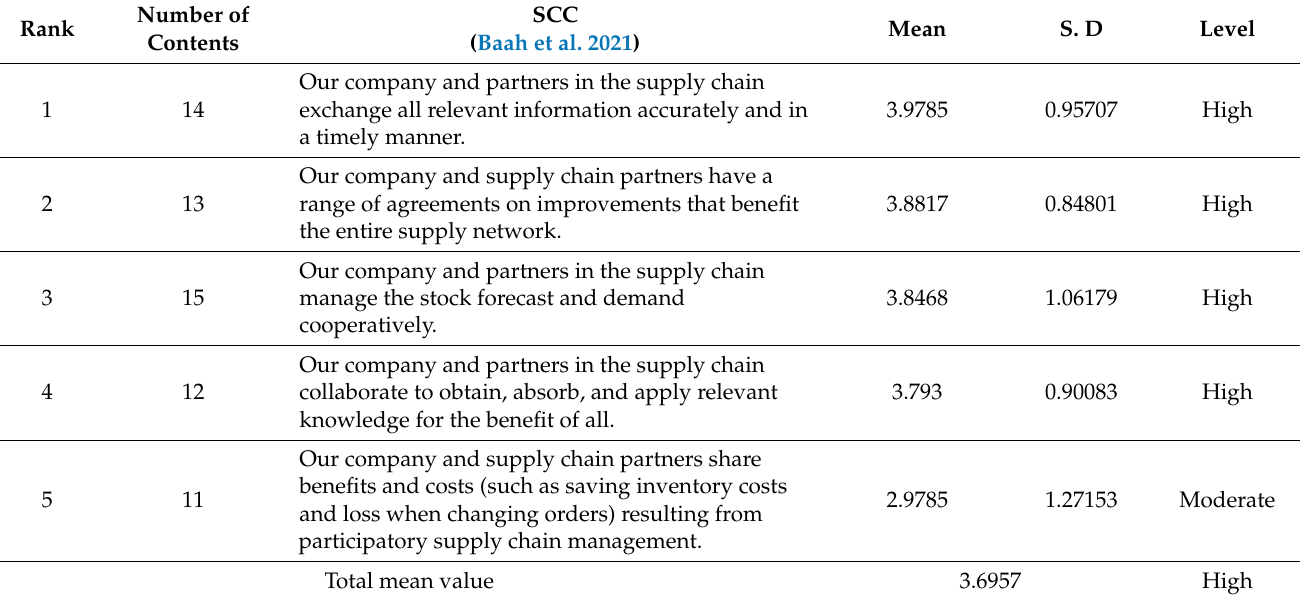
Table 4. Descriptive analysis—SCC items (N = 372).